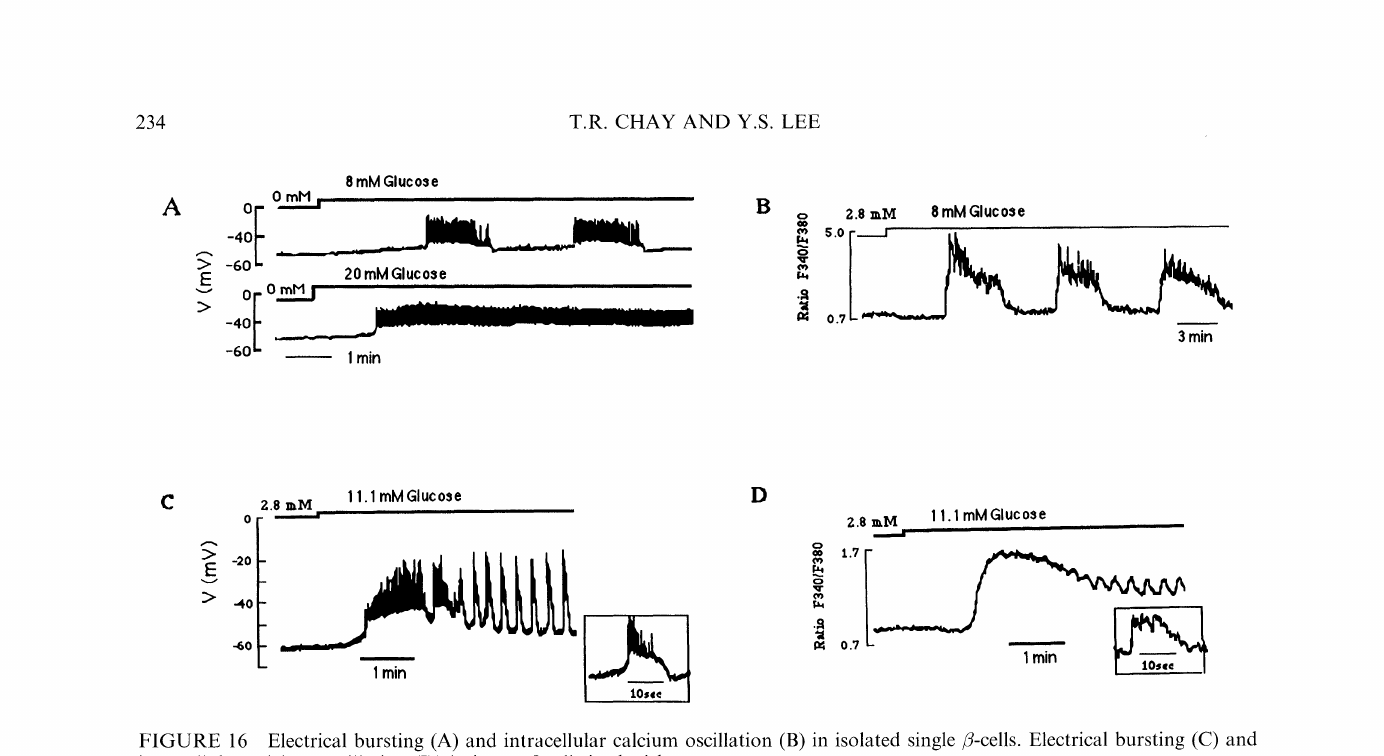
FIGURE 16 Electrical bursting (A) and intracellular calcium oscillation (B) in isolated single/3-cells. Electrical bursting (C) and intracellular calcium oscillation (D) in intact 3-cells in the